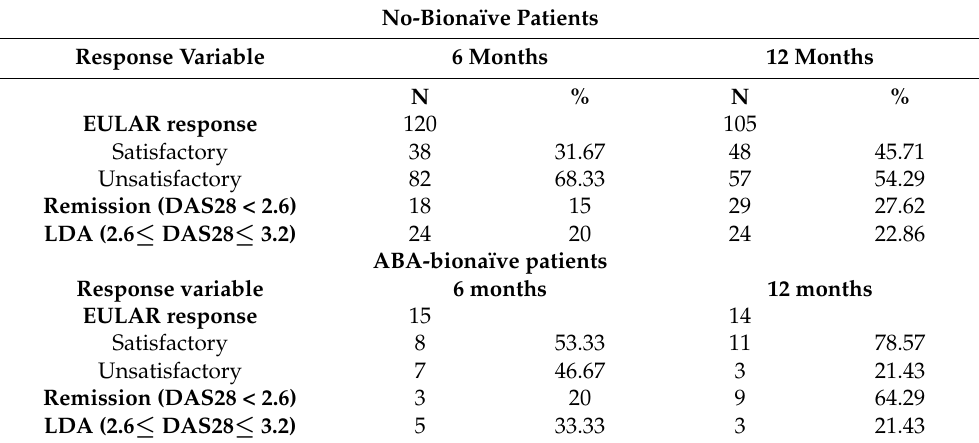
Table 2. Clinical Effectiveness of Abatacept in no-bionaïve and ABA-bionaïve